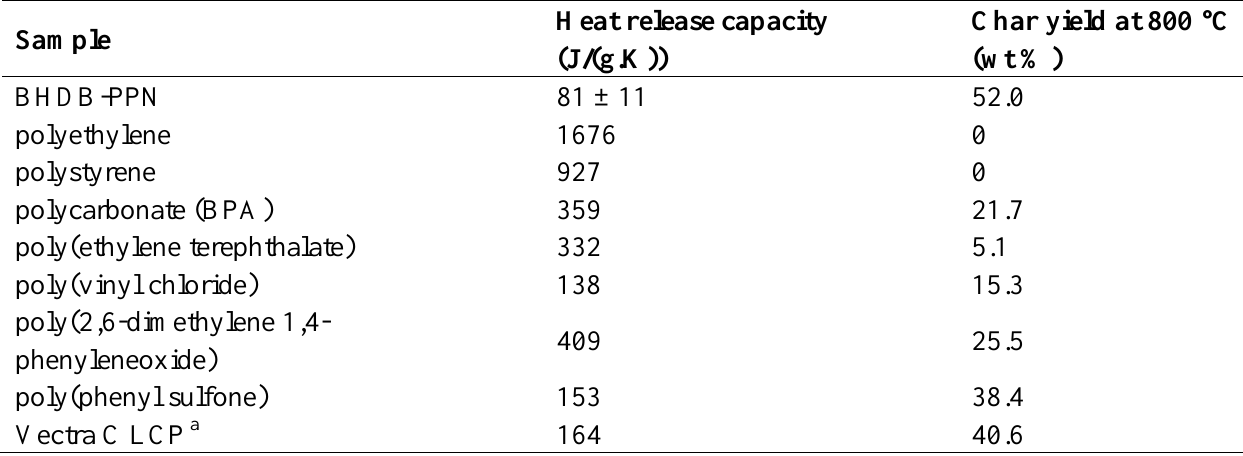
Table 3. Measured heat release capacities of BHDB-PPN and other reference